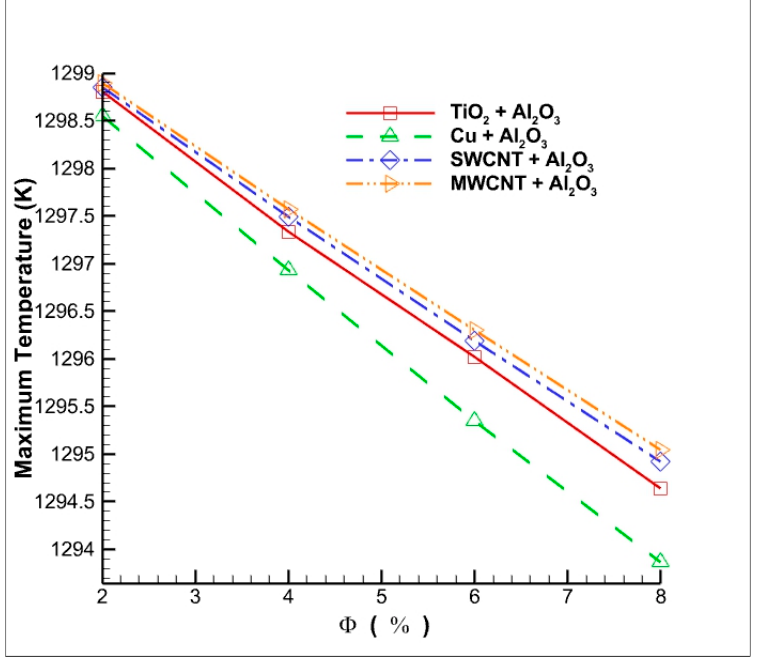
Figure 6. Variation of maximum drill bit temperature with different volume fractions of dispersed nanoparticles.